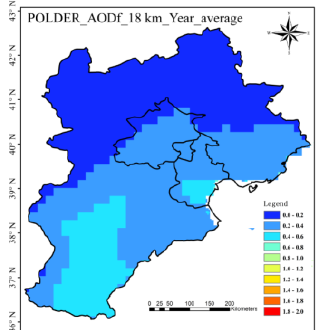
Figure 3. The yearly averaged AOD f products at 550 nm of POLDER for 18